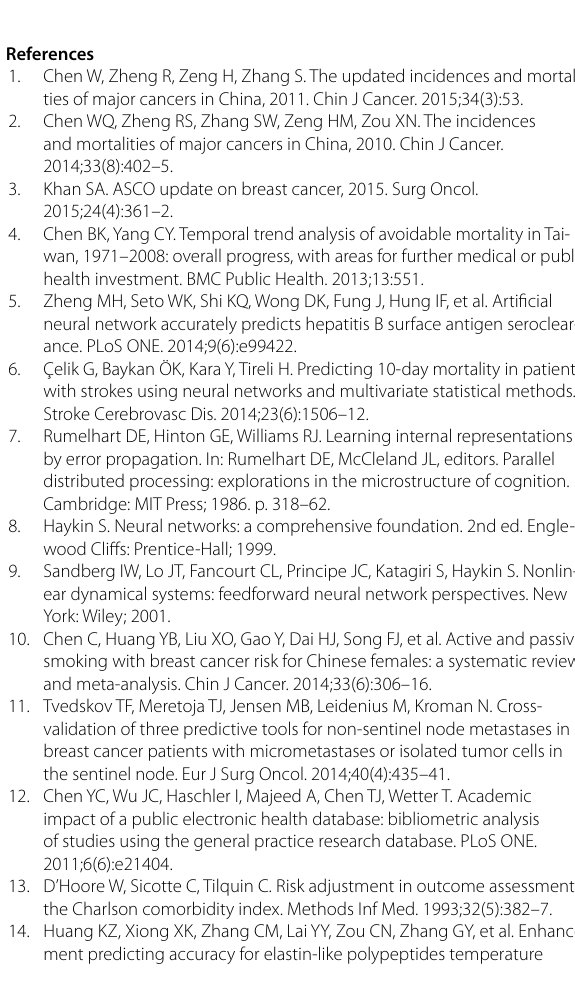
PPV positive predictive value, NPV negative predictive value, AUC area under receiver operating characteristic